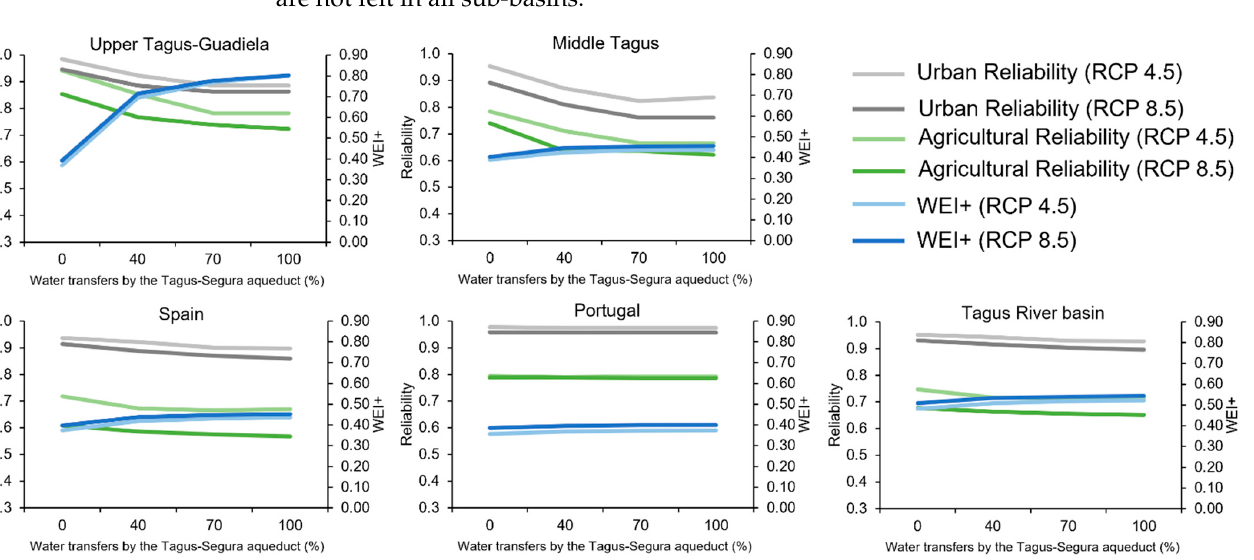
Figure 8. Alternative 2 for reductions in water demand at a local and transboundary level for the mid-term horizon (2040–2070) under RCP 4.5 and RCP 8.5.